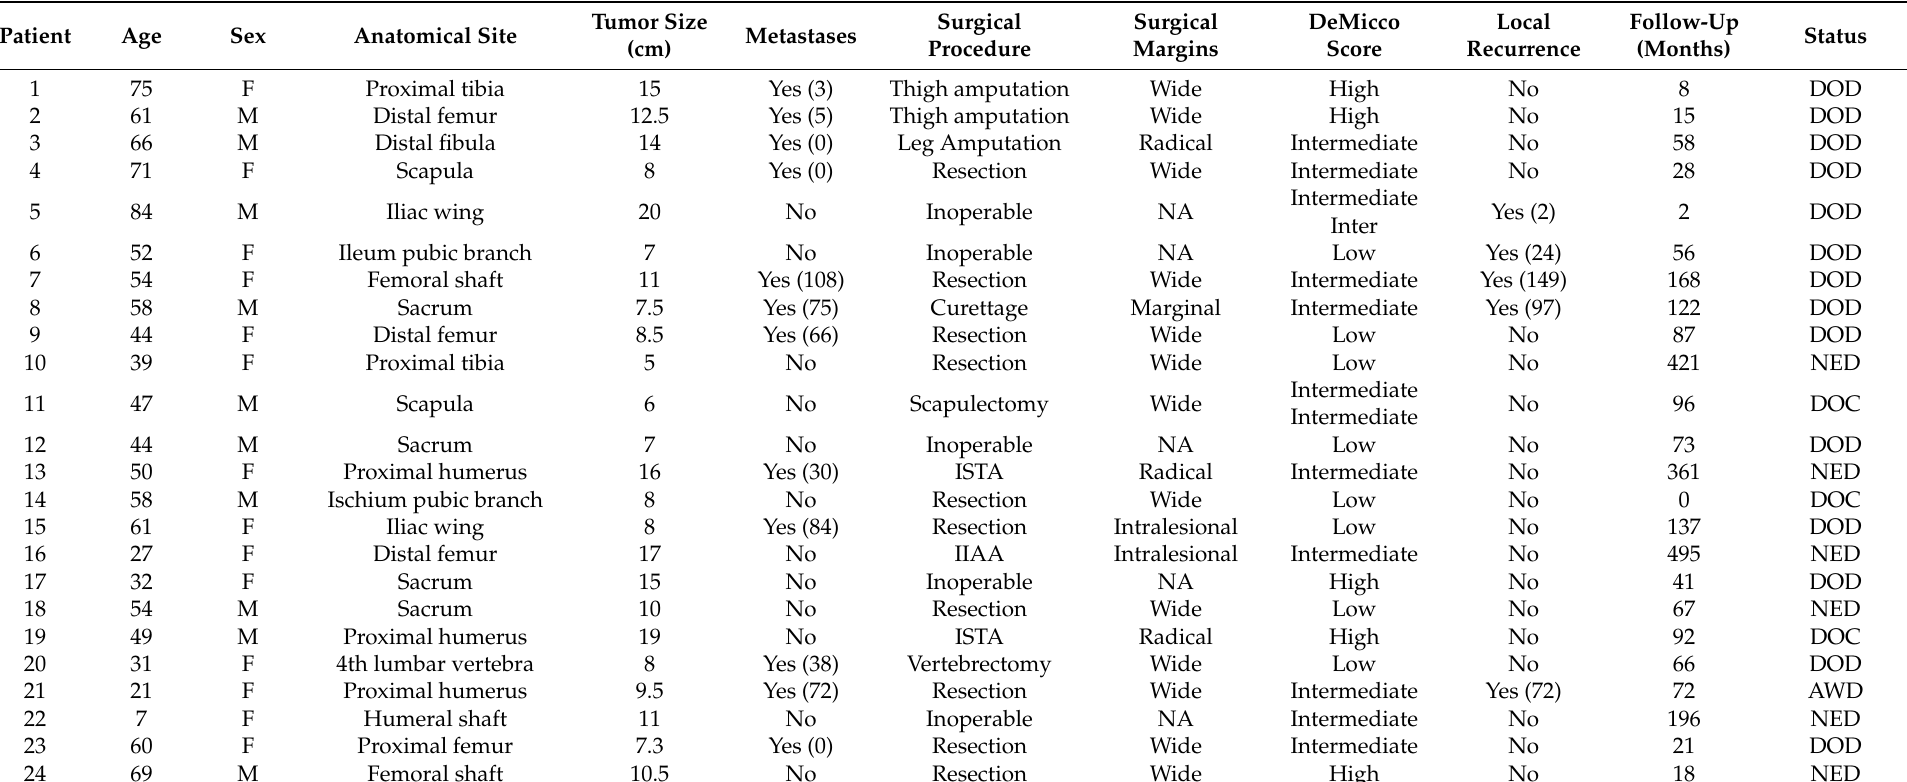
Table 1. Clinical features of 24 patients with a diagnosis of primary SFT of the